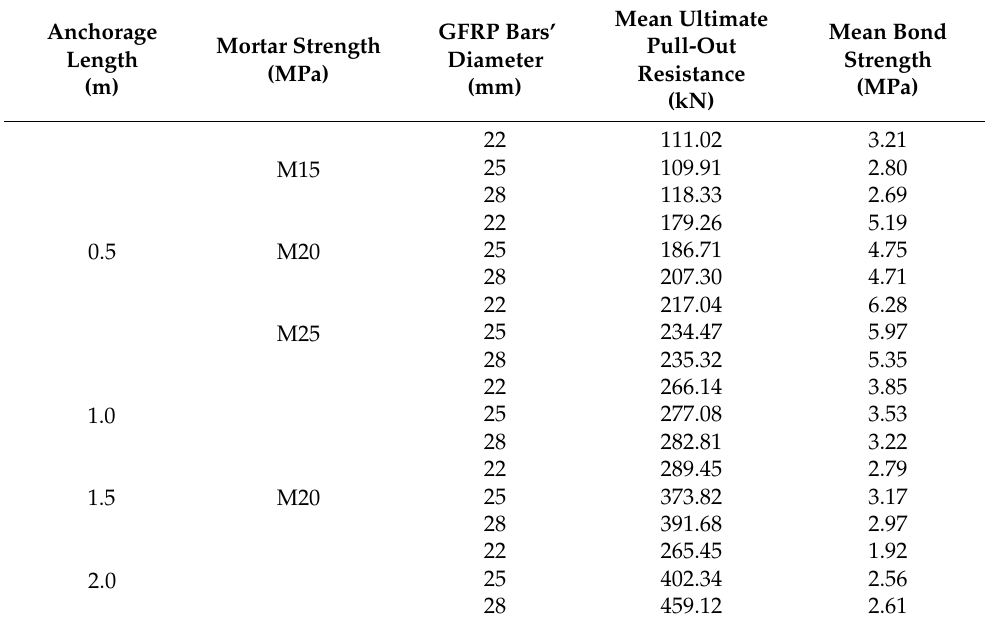
Table 4. Results of Bond and Pull-out Test on GFRP Bolts.